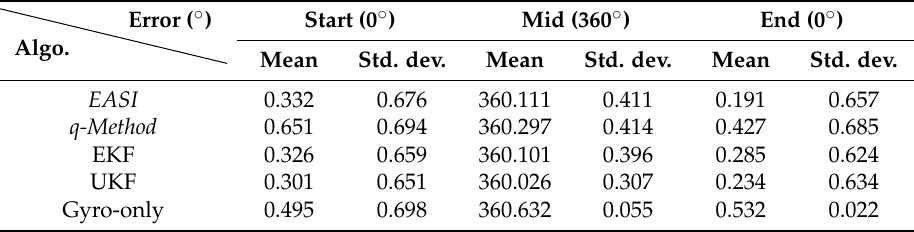
Table 5. Statistical comparison of heading estimation algorithms in the continuous Tip test.